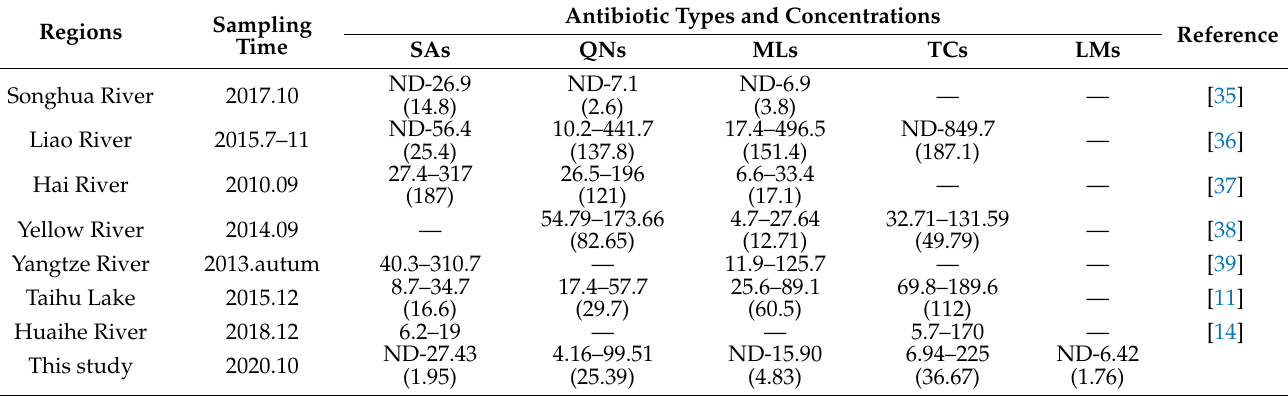
Table 4. The concentration of antibiotics in surface water in China (ng · L − 1